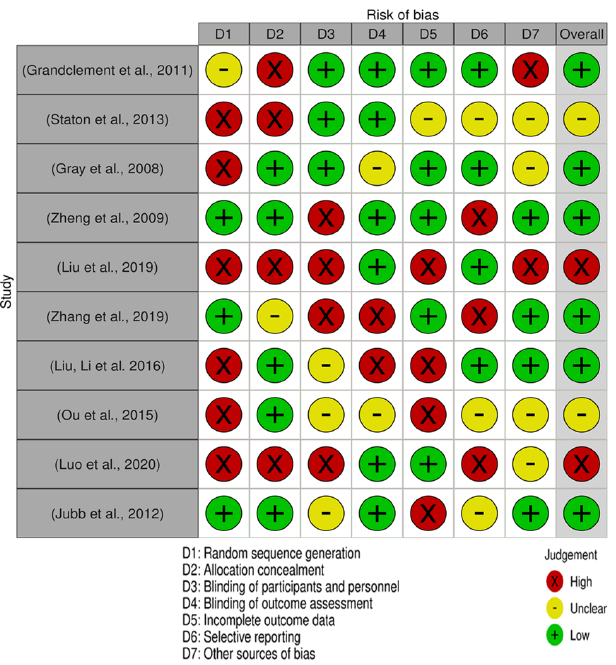
Figure 4. Risk of bias summary for each included study. The Cochrane risk-of-bias assessment for the 10 articles included in this review. In terms of random sequence generation, 6 studies had a low risk of bias while 4 had high risk of bias. Concerning the risk of allocation concealment, 5 studies had a low risk of bias and 5 has a high risk of bias. In the selective reporting domain, 4 studies had a low risk of bias, 3 unclear, and 3 had high.